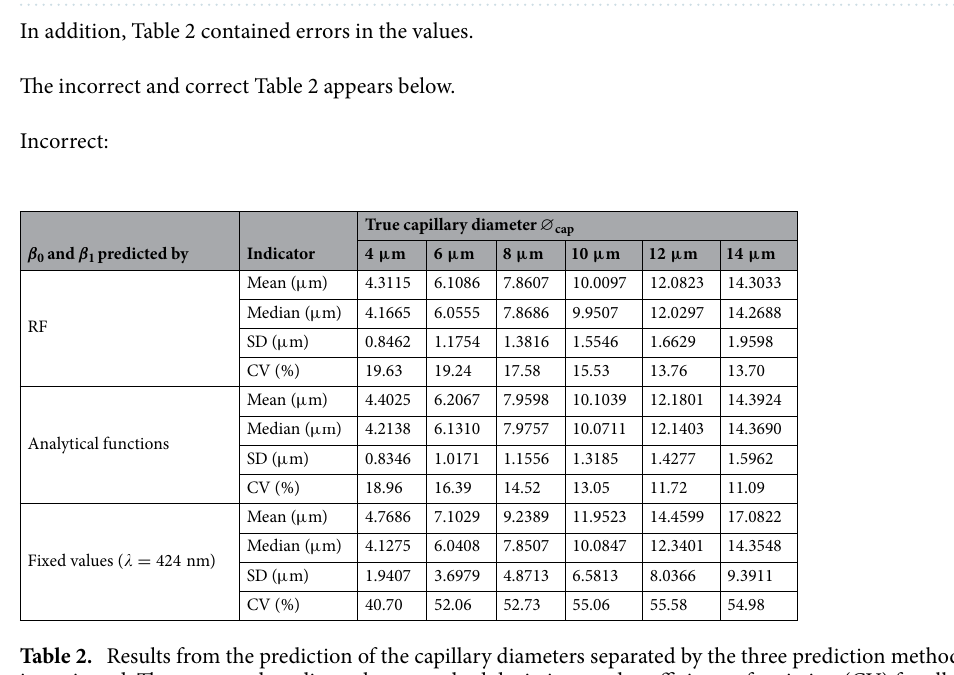
Table 2. Results from the prediction of the capillary diameters separated by the three prediction methods investigated. The mean and median values, standard deviations and coefficients of variation (CV) for all methods and capillary diameters are given. A graphical representation of this data can be found in Fig. 5.